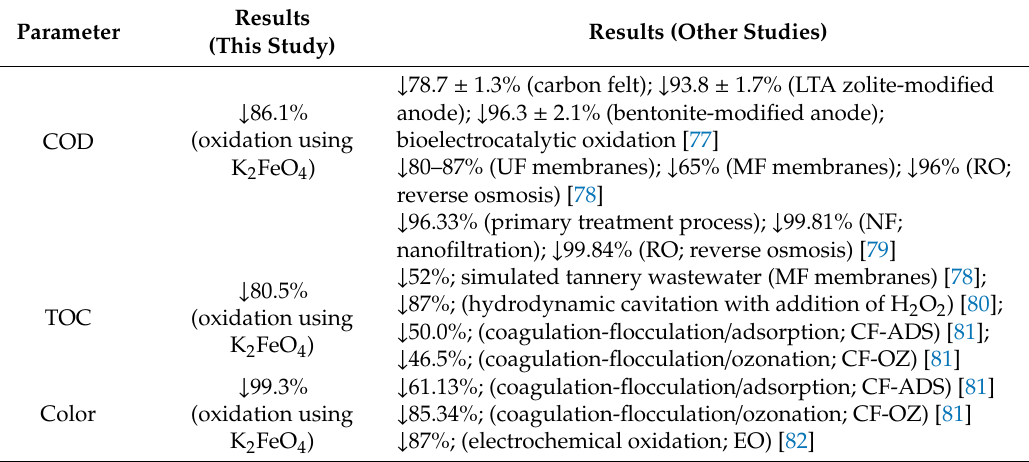
Table 10. The removal of color, COD, and TOC from tannery wastewater by using selected